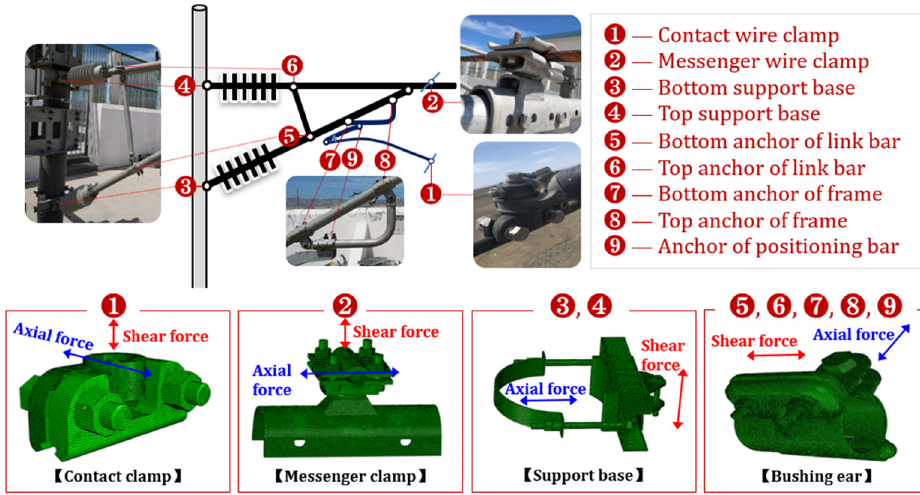
Figure 13: Connection components numbering and precise FE